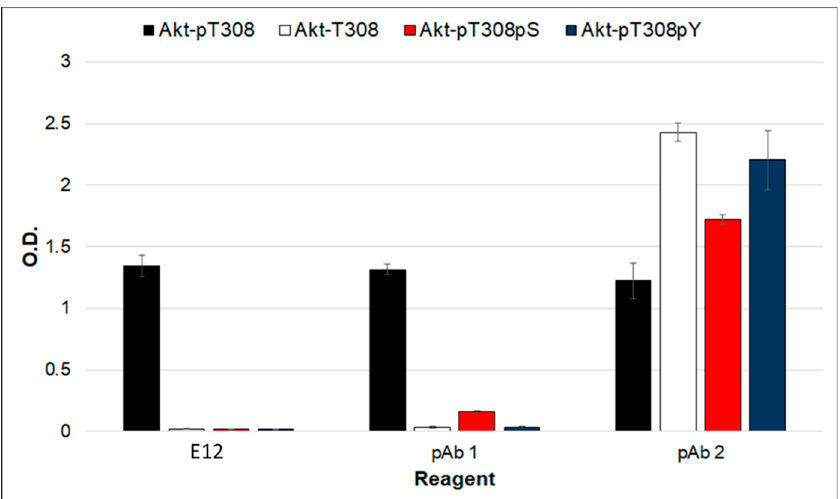
Figure 5 . Binding of an Akt1-pTBD to a set of related peptides. A set of biotinylated phosphopeptides containing the Akt1 sequence were synthesized with threonine (Akt-T308), pS (Akt-pS308) or pY (Akt-pY308) substituted at the pT position and immobilized by neutravidin. Binding of the E12 variant and two commercially produced polyclonal antibodies were determined by an ELISA. Error bars represent standard deviation of triplicate measurements.